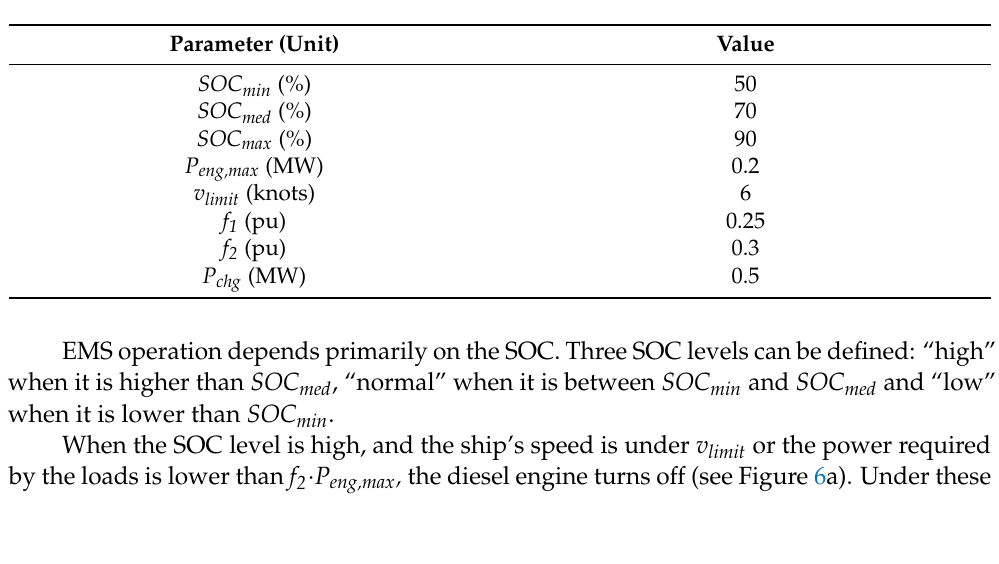
Figure 6. EMS operation under different SOC conditions: ( a ) SOC is high; ( b ) SOC is normal; ( c ) SOC is low. Table 6. Parameters of the induction motor.